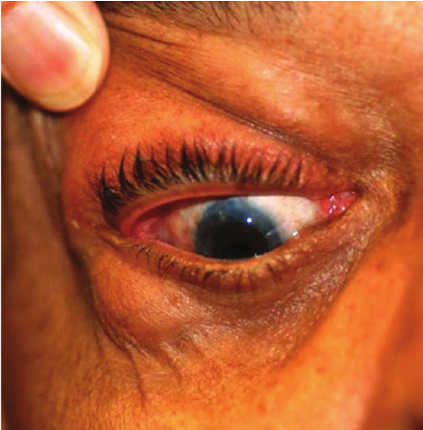
Figure 1: “Salmon pink,” painful masses of the right and left orbits locatedinthetemporalaspectsoftheanteriororbits,whichhadbeen growing over the past twelve months.